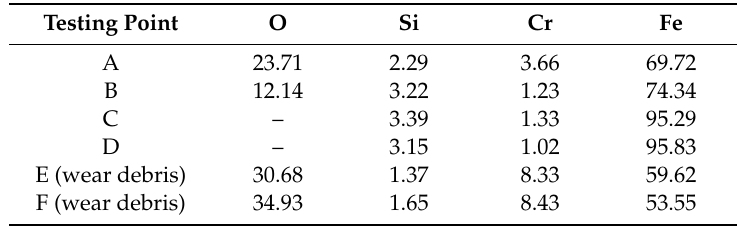
Table 5. EDS results of the worn surface of Fe-based alloy coating (in